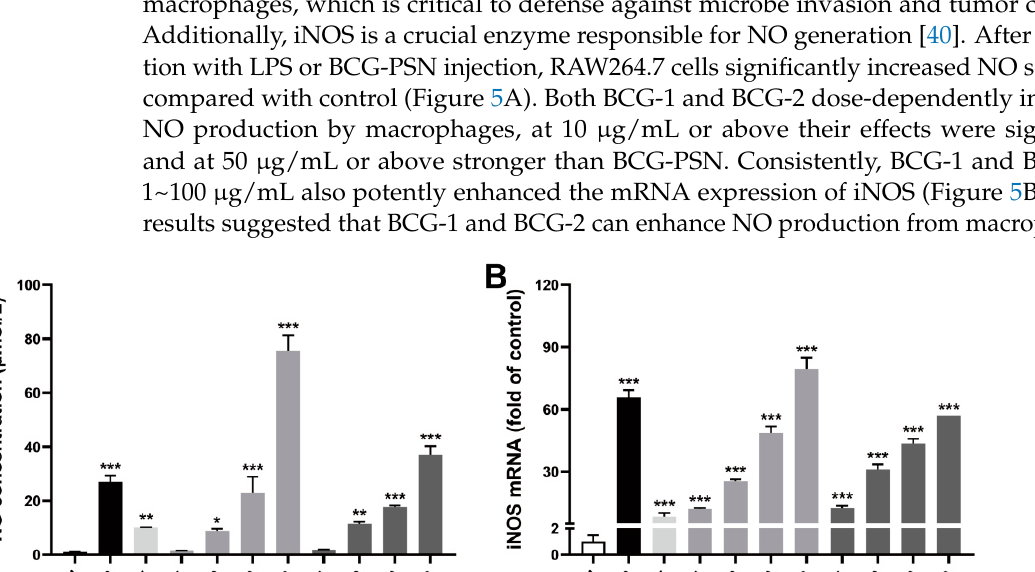
Figure 4. Proposed structures of BCG-1 ( A ) and BCG-2 ( B ) purified from BCG-PSN.